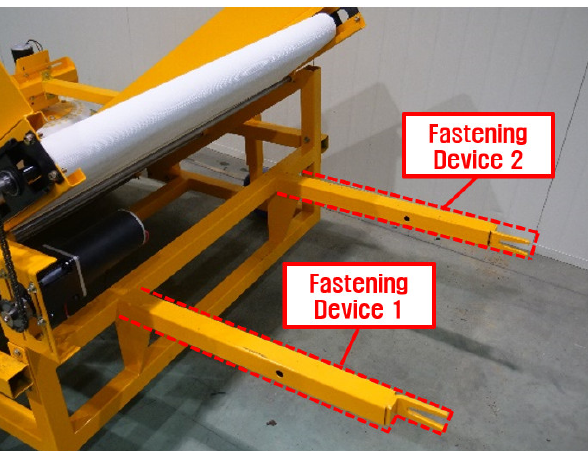
Figure 1. Shape of agricultural by-product collector.